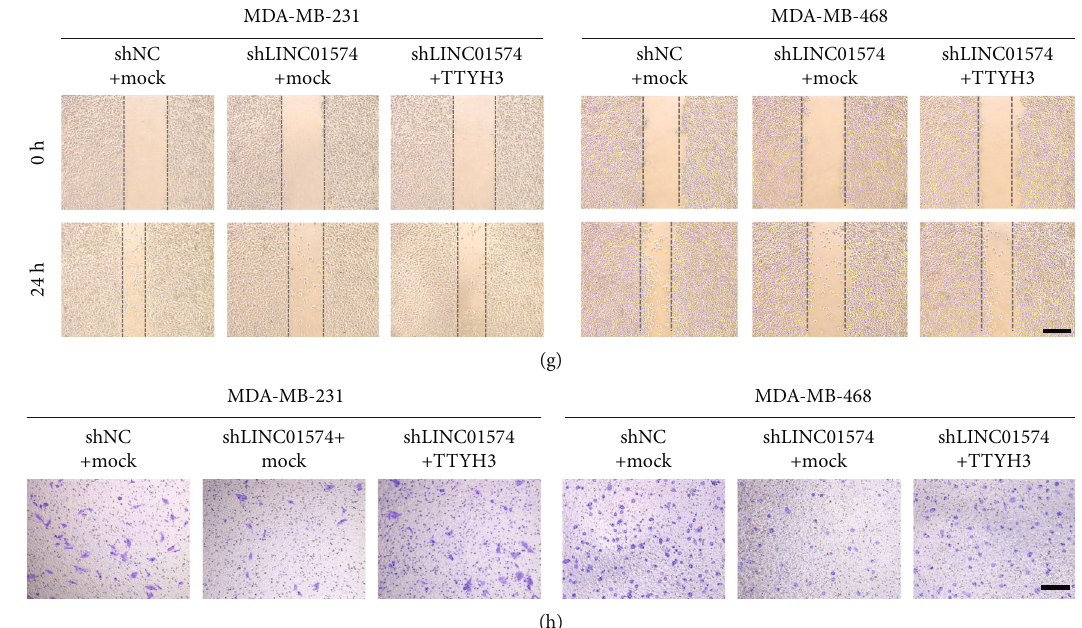
Figure 7: LINC01574 regulated BC cell proliferation, migration, and invasion by targeting TTYH3. (a, b) The transcription and translation levels of TTYH3 were quantitatively detected in BC cells. (c, d) After corresponding transfection, the OD value and cloning numbers of BC cells in di ff erent groups (shNC+mock, shLINC01574+mock, and shLINC01574+TTYH3) were evaluated. (e – h) After corresponding transfection, the migration and invasion capabilities of BC cells in di ff erent groups (shNC+mock, shLINC01574+mock, and shLINC01574+TTYH3) were evaluated. ∗ P < 0 : 05 , ∗∗ P < 0 : 01 , and ∗∗∗ P < 0 : 001